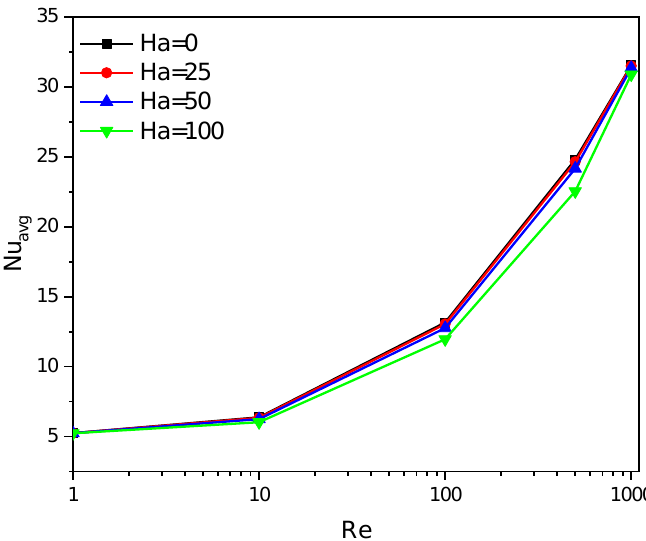
Figure 9. Effects of the Ha number on the Nu avg at Ha = 0 , 𝑆𝑡𝑒 = 0.2.